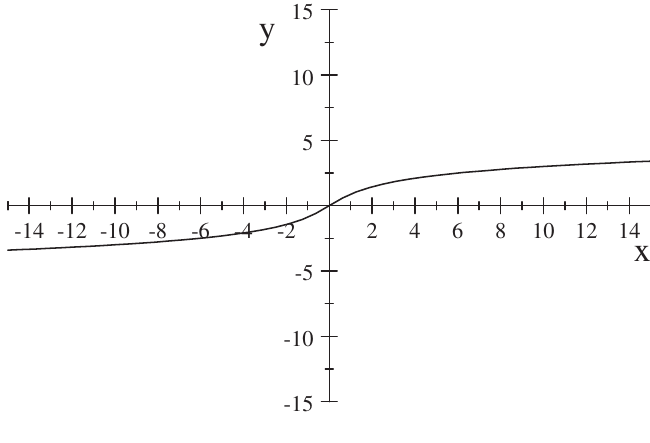
Fig. 1. The inverse hyperbolic sine function